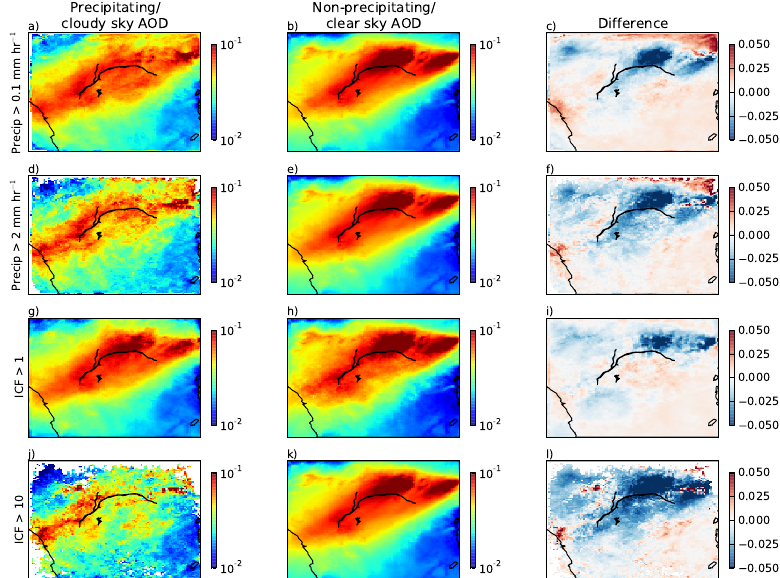
Figure 4. The influence of wet scavenging on AOD in WRF-Chem. Each of the rows uses a different criterion to define clear/cloudy sky. The top two rows use surface precipitation, with precipitation over 0.1 and 2mmh − 1 defined as cloudy regions. The bottom two rows define cloudy as an integrated cloud flag of greater than 1 and greater than 10. From left to right, the columns show the cloudy-sky AOD, the clear-sky AOD and the difference, with blue indicating a lower AOD in the cloudy